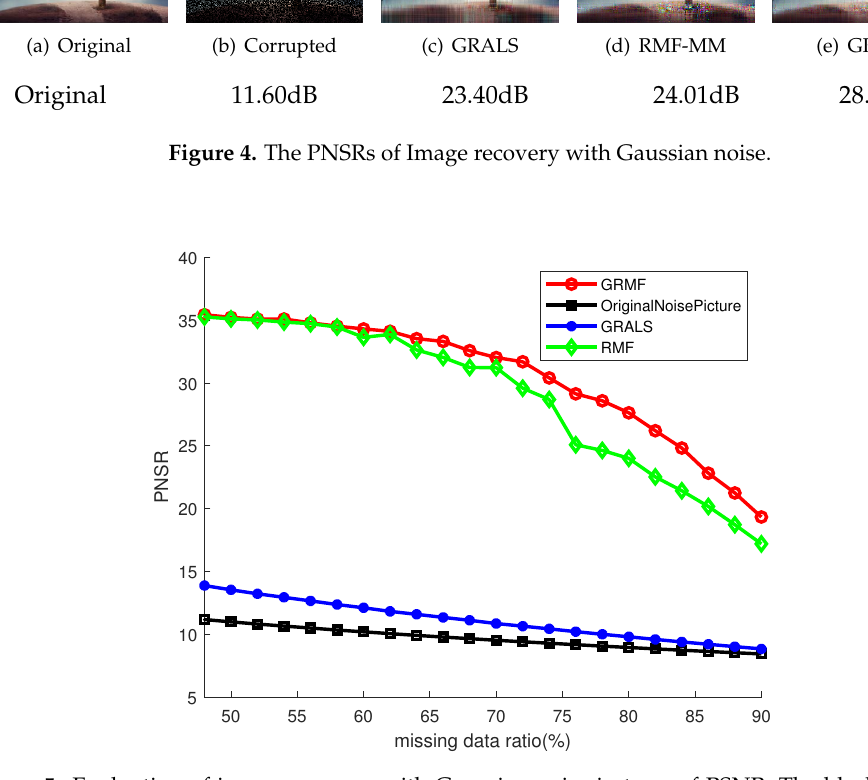
Figure 5. Evaluation of image recovery with Gaussian noise in term of PSNR. The black line that marked with “Corrupted” means the PNSR of the corrupted